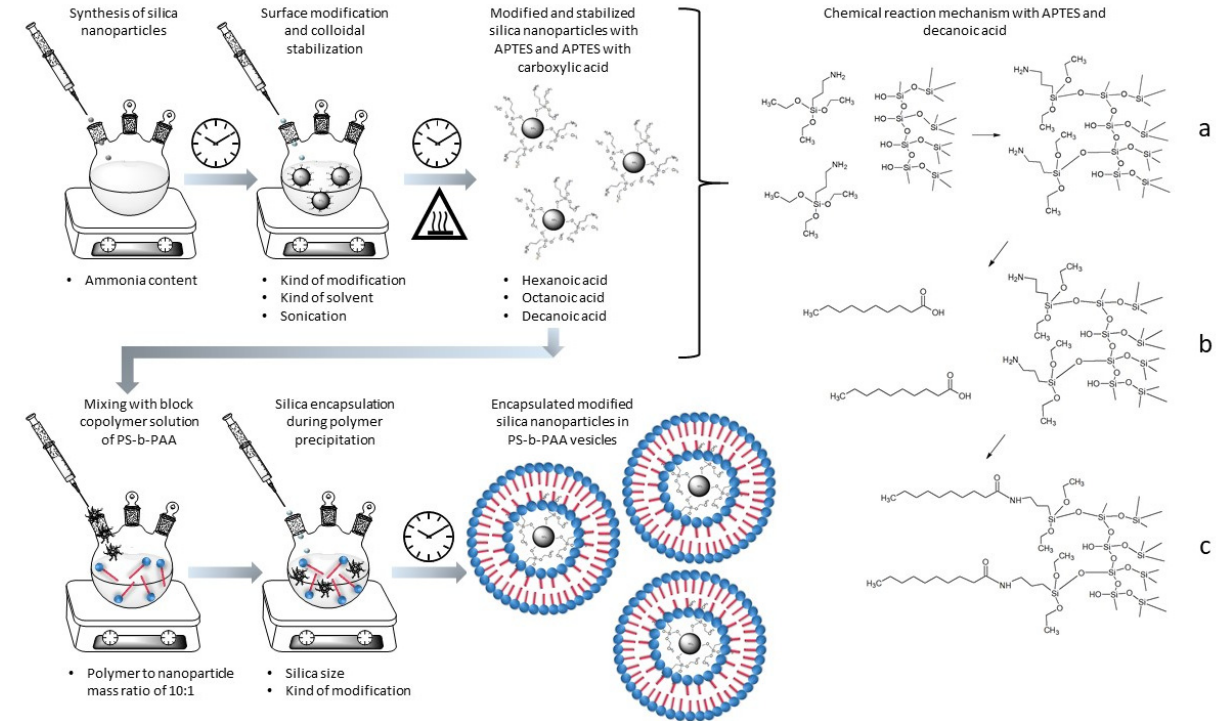
Figure 2. Schematic representation of the process for the production of the self-assembled nanopar- ticle–polymer hybrids from silica and PS-b-PAA vesicles, involving synthesis, surface modification, colloidal stabilization, and encapsulation with the co-precipitation method as well as the illustration of the reaction mechanism of the two-stage modification method using the example with APTES and decanoic acid. ( a ) First modification step by chemically coupling APTES to the silica surface, ( b ) addition of decanoic acid to the APTES-modified silica nanoparticles, and ( c ) second modification step by chemically coupling decanoic acid to the silica–APTES surface.